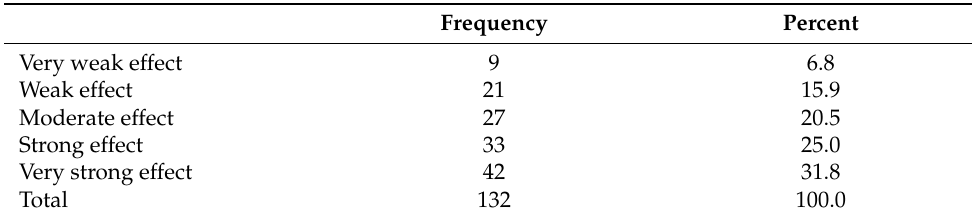
Table 8. Effect of corruption on the valuation profession.